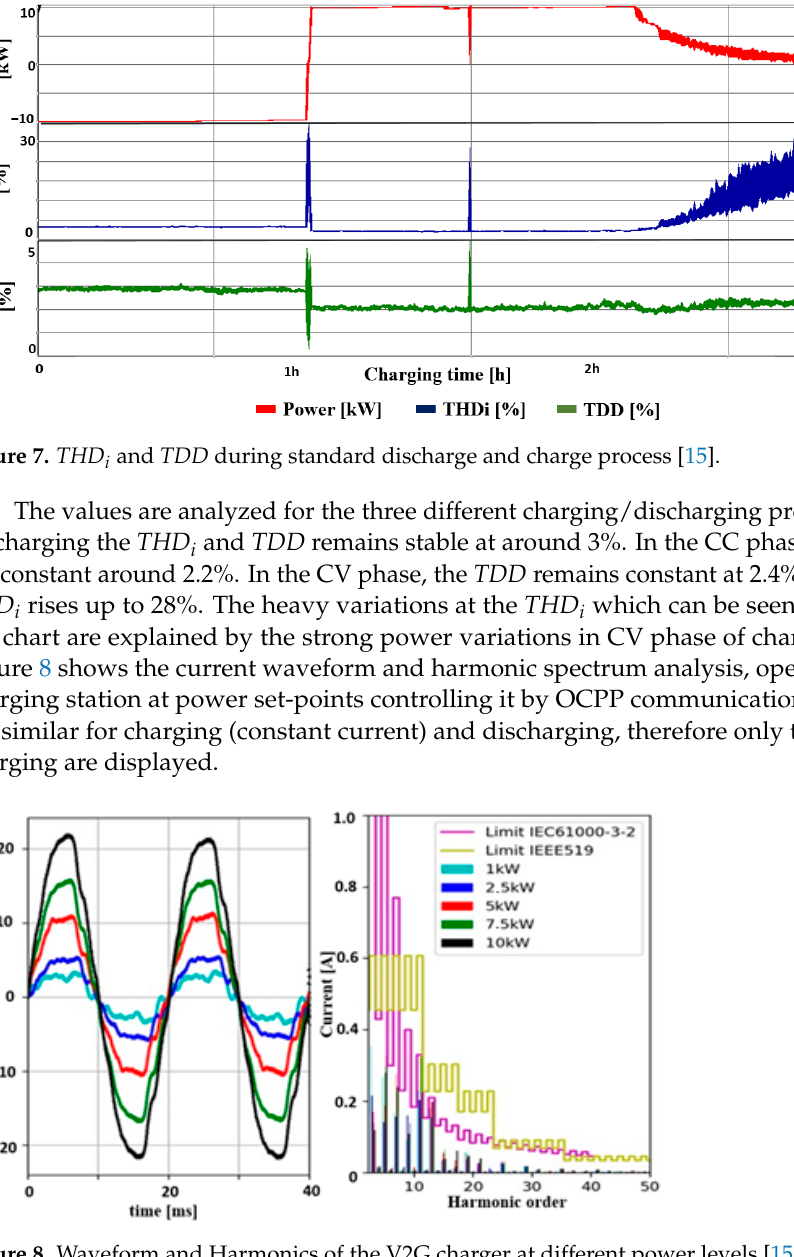
Figure 6. Active Power and SoC during discharge and charge.